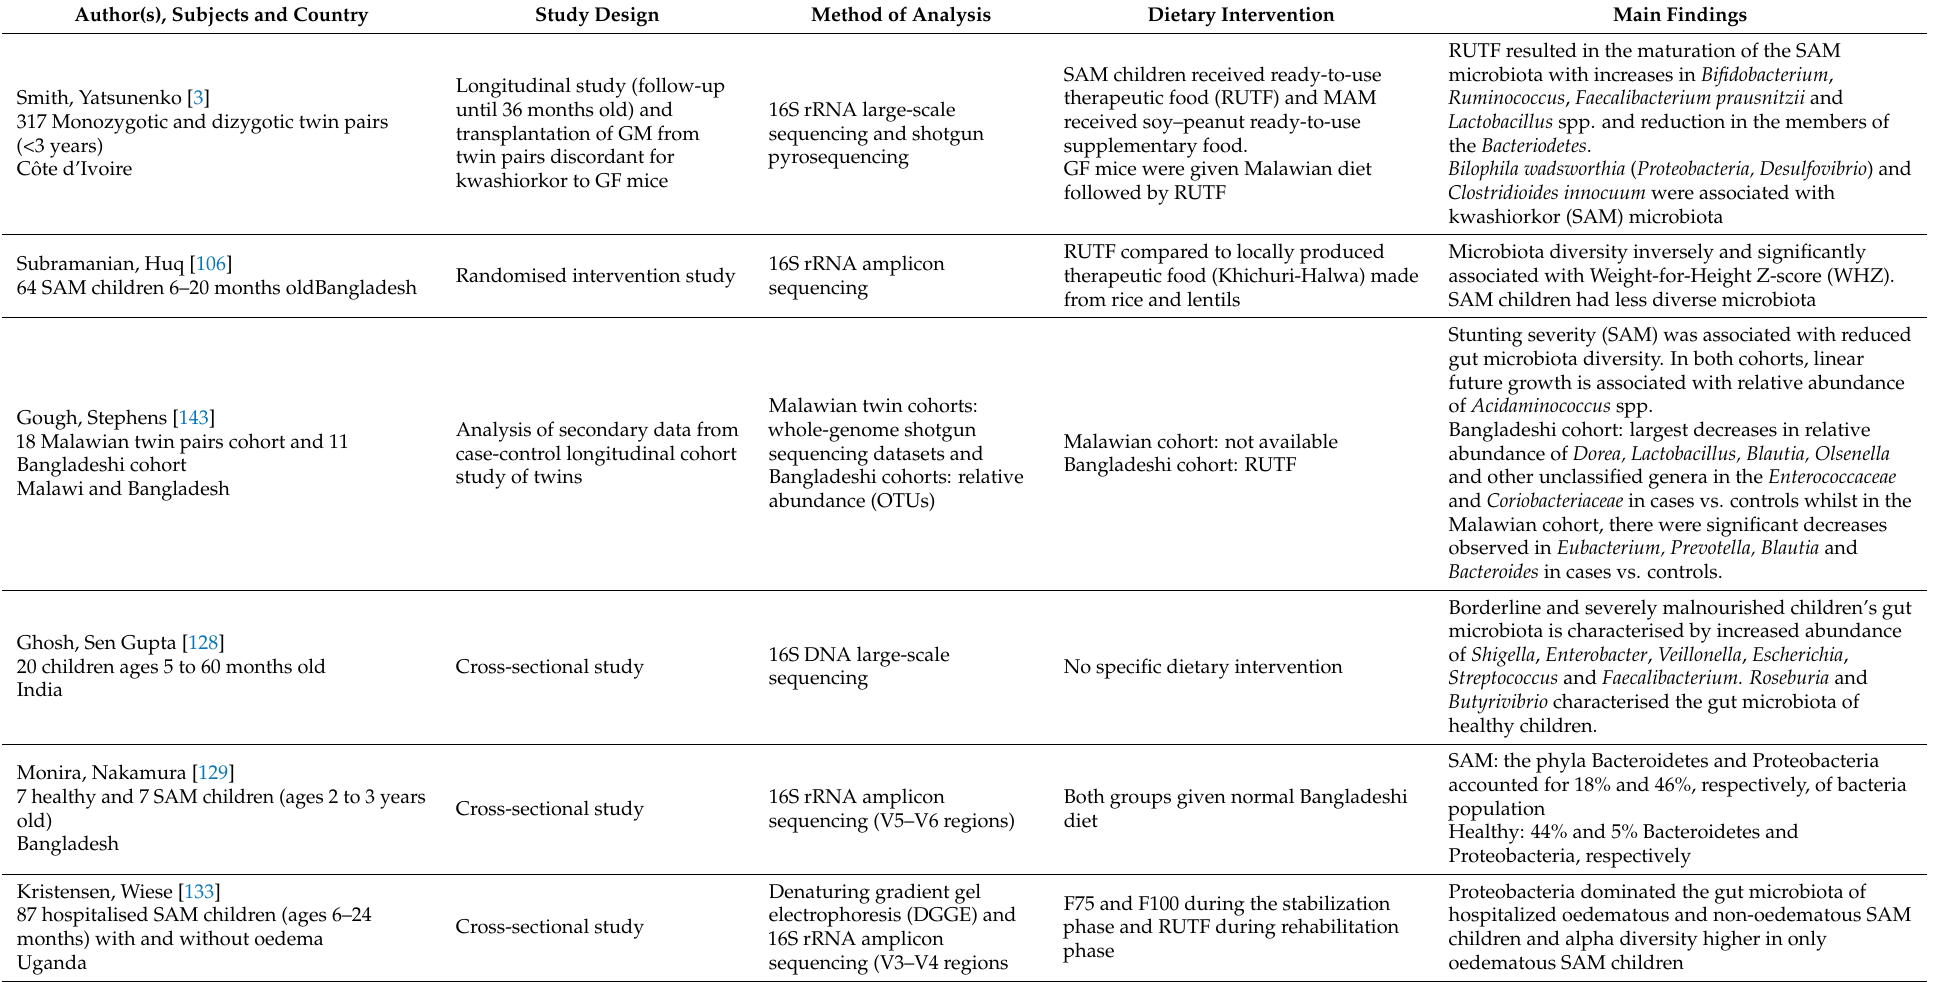
Table 1. Summary of the main findings of studies on infant and young child gut microbiota alteration during